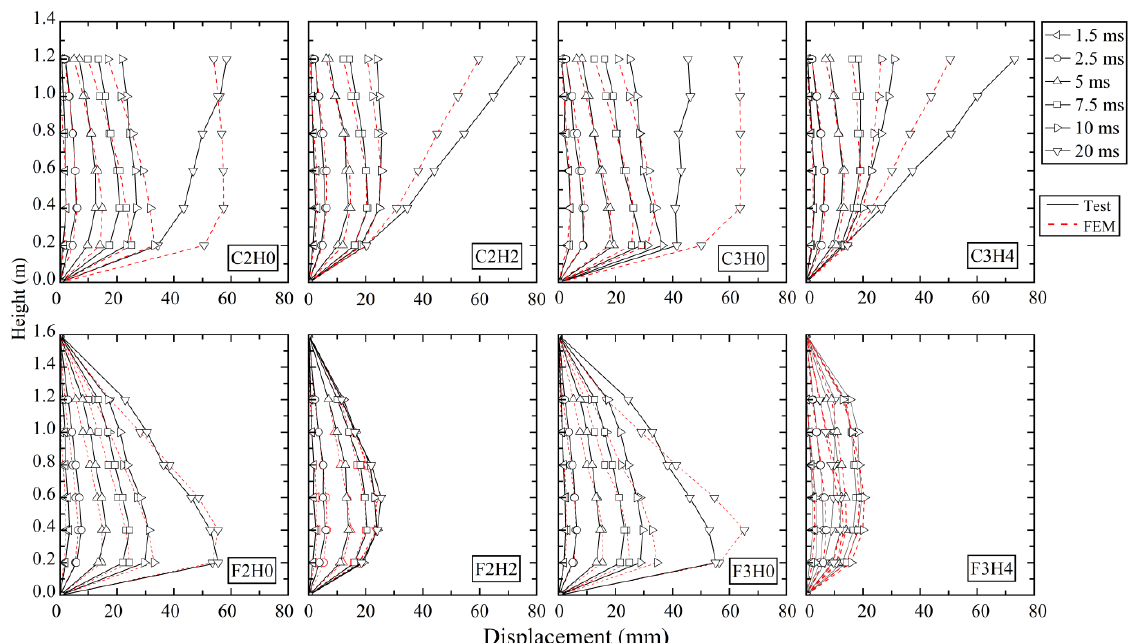
Figure 4. Comparison of horizontal displacement distribution.